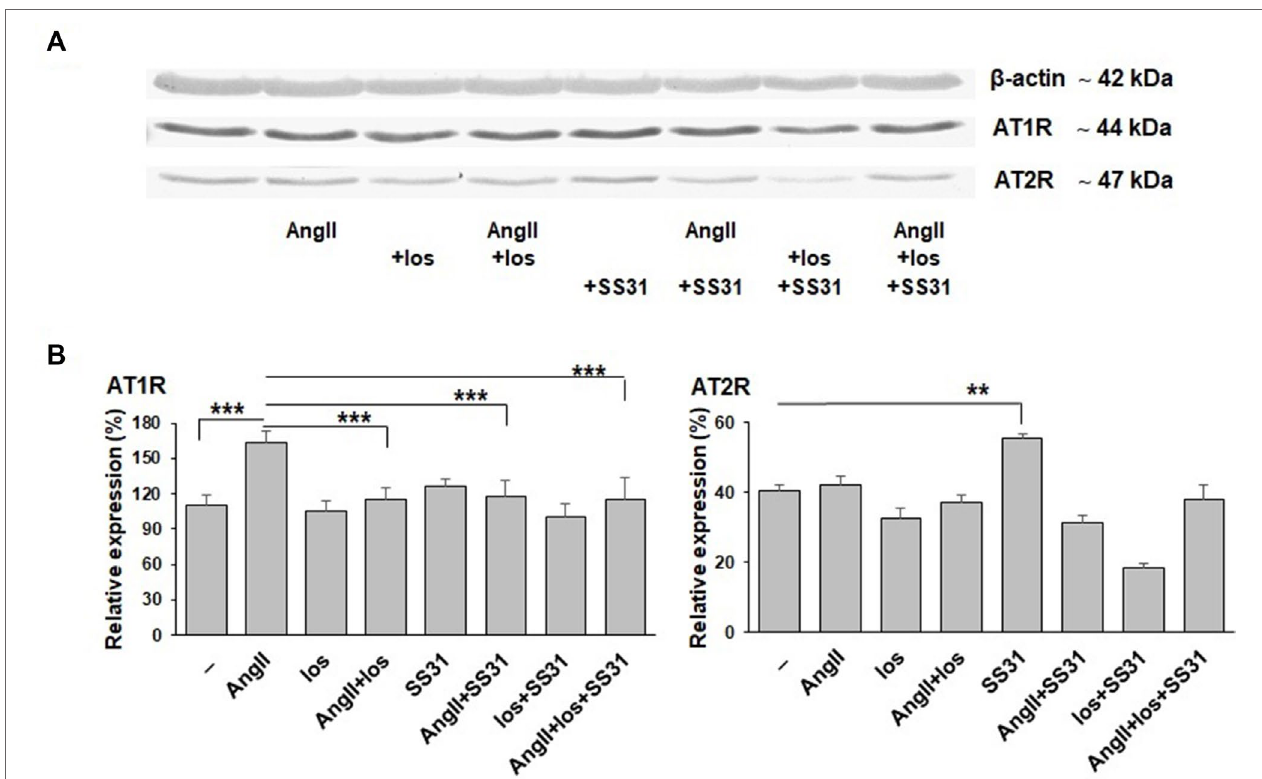
FIGURE 5 | Expression of AT 1 R and AT 2 R proteins by EC219 cells exposed to Ang II, an AT 1 R antagonist (losartan) and SS-31. The expression of AT 1 R and AT 2 R by EC219 cells exposed for 24 h to either Ang II, the AT 1 R antagonist losartan or SS-31, or their combination, were analyzed by western blotting: (one representative blot, (A) , then quantified (3 experiments, (B) by comparison with the expression of β -actin as a control. (**p < 0.01; ***p <